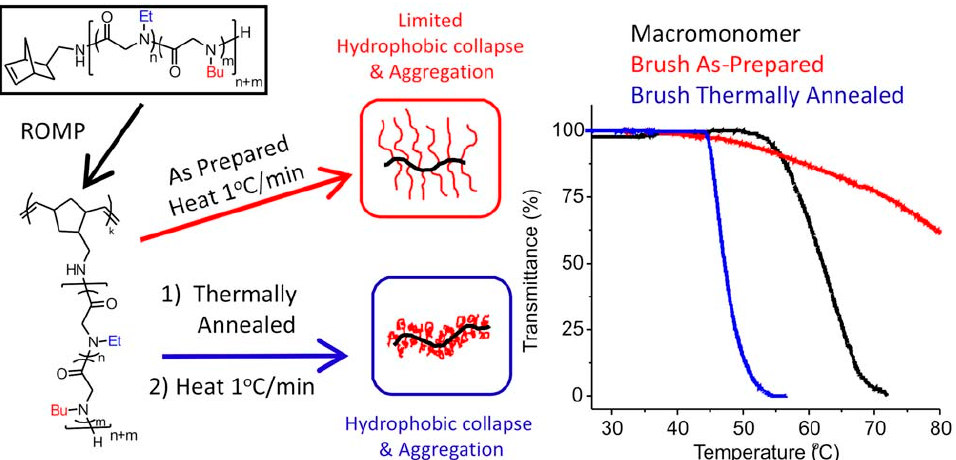
Figure 7. Structure of polypeptoid bottlebrush copolymers and schematic illustration of the level of aggregation in as-prepared or thermally annealed solutions of the polypeptoid bottlebrushes. Reprinted with permission from [58] . Copyright 2014, Royal Society of Chemistry.